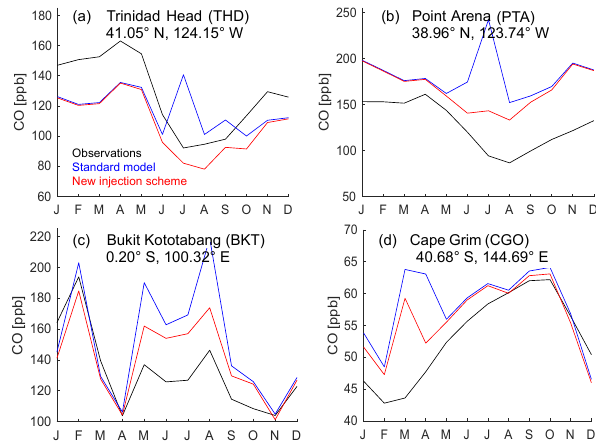
Figure 10. Observed and simulated monthly mean CO mixing ra- tios at select NOAA ESRL Carbon Cycle Cooperative Global Air Sampling Network